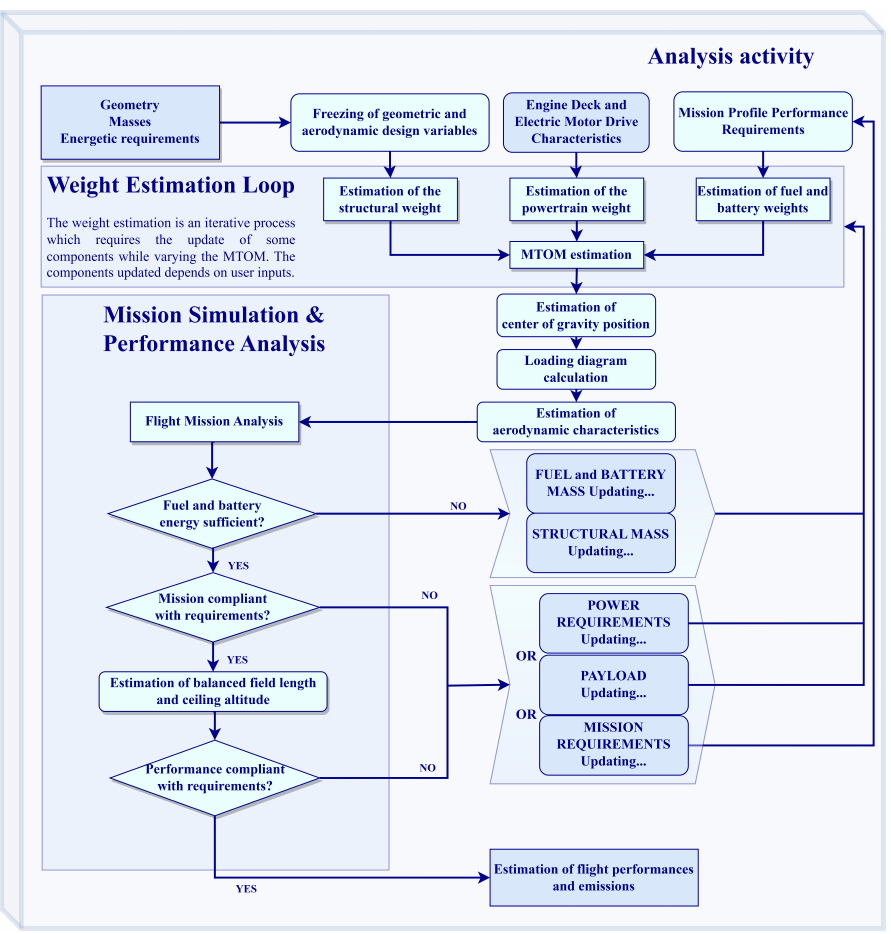
Figure 3. Workflow of the analysis module of